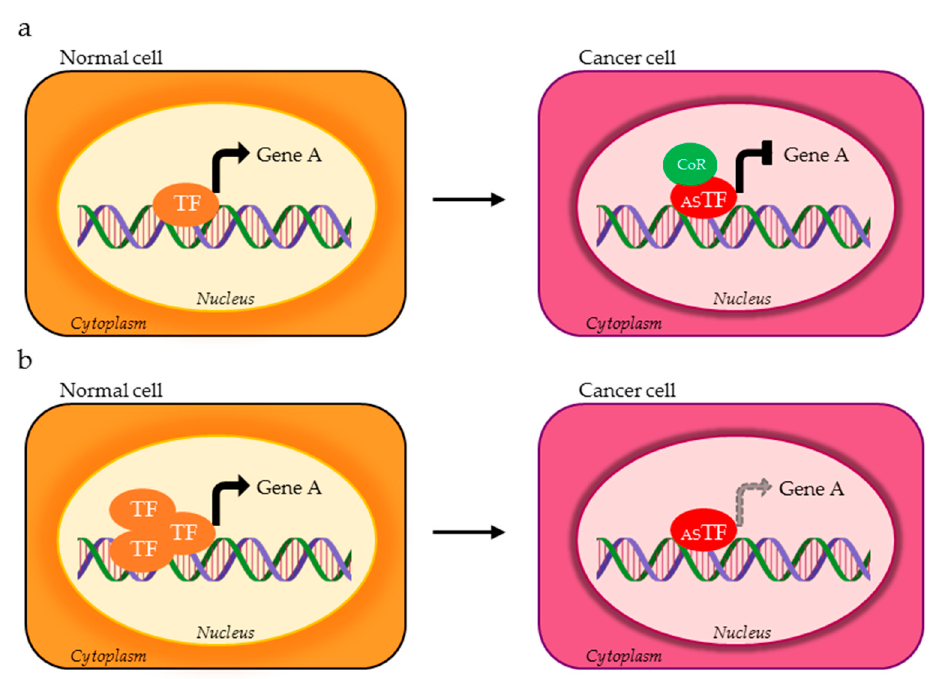
Figure 2. TF isoforms expressed in cancer cells (red AS TF) can (a) oppositely control the expression of the same target gene compared to the physiological TF variant (orange TF) through the recruitment of different co-regulators (green CoR) or (b) have reduced affinity for the target